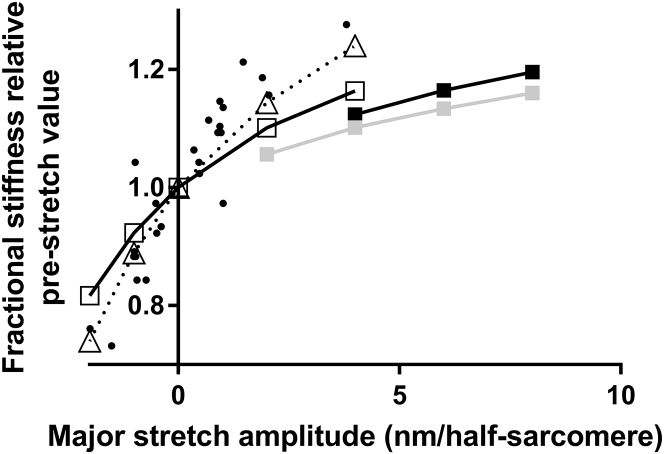
Half-sarcomere stiffness upon stretch ramps (main stretch) of different amplitudes normalized to the stiffness before the stretch. Squares and triangles: simulated data on the assumption of nonlinear cross-bridge elasticity and linear myofilament elasticity. The cross-bridge elasticity was assumed similar to that in (29). Model data are given for main stretches imposed 1 s after a prestretch of amplitude 0 nm (open symbols), 1 nm (black squares), or 2 nm (gray squares). For the case of 0 nm prestretch, data were simulated for two different levels of myofilament stiffness: 150 pN/nm (squares) and 250 pN/nm (triangles). Negative stretch corresponds to shortening. Simulated data are connected by lines for clarity. Velocity of the simulated length changes was 10 nm/s for all cases. A thousandfold increase in velocity did not change the results. The simulated data are superimposed on experimental results from (24) (small full circles; measured from their Fig. 5).